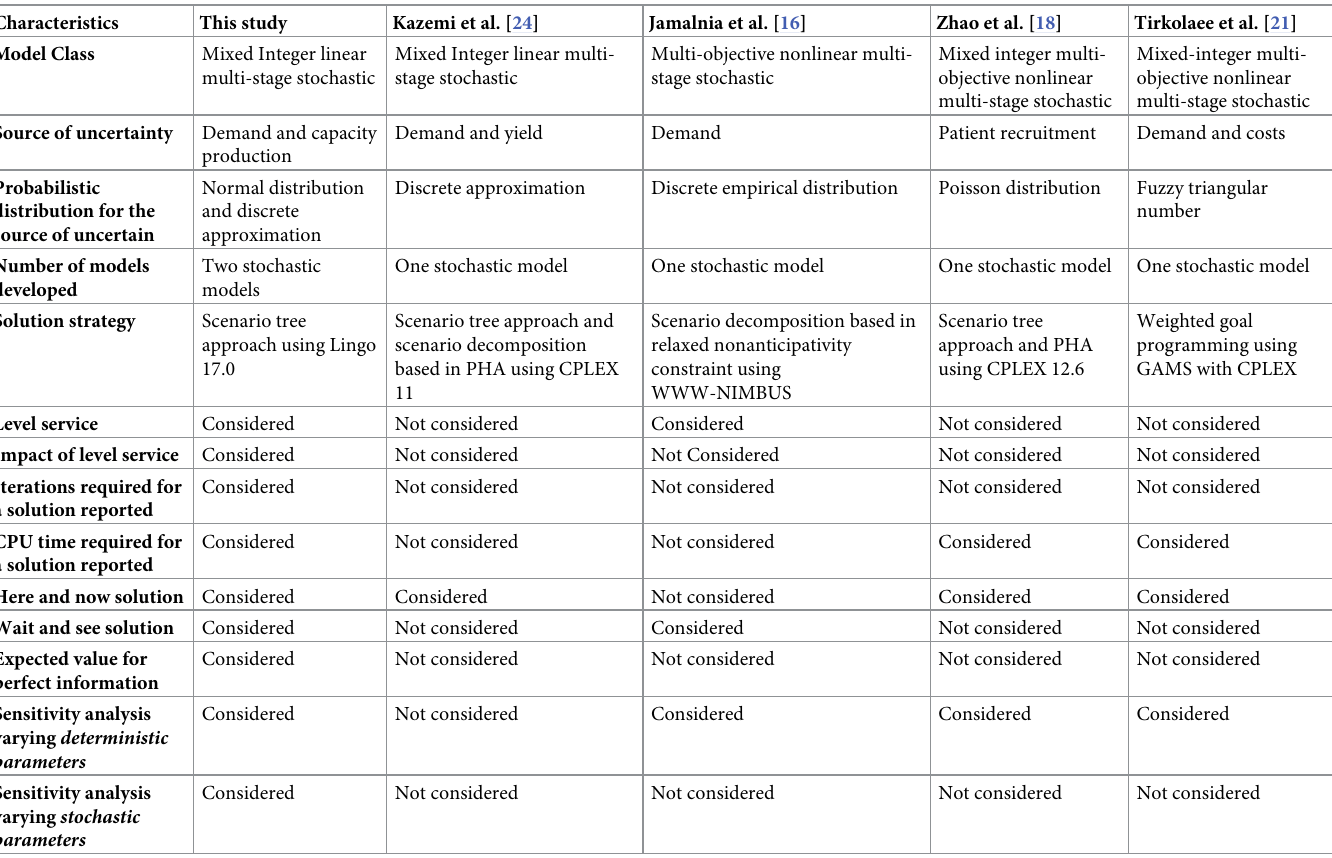
Table 1. Studies about APP with uncertainty. Own